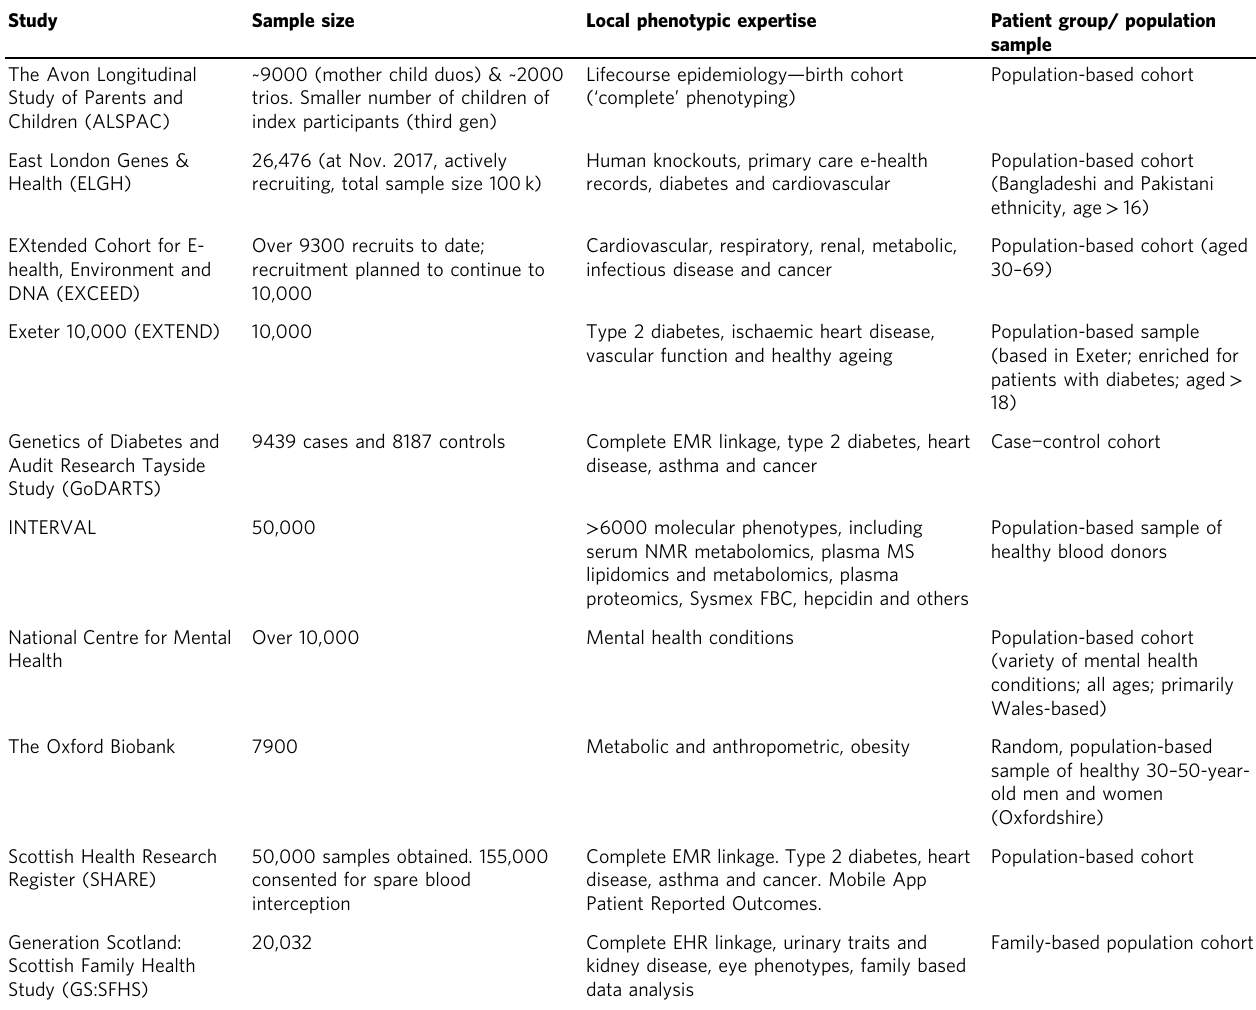
Table 1 UK patient and population-based studies available for RbG